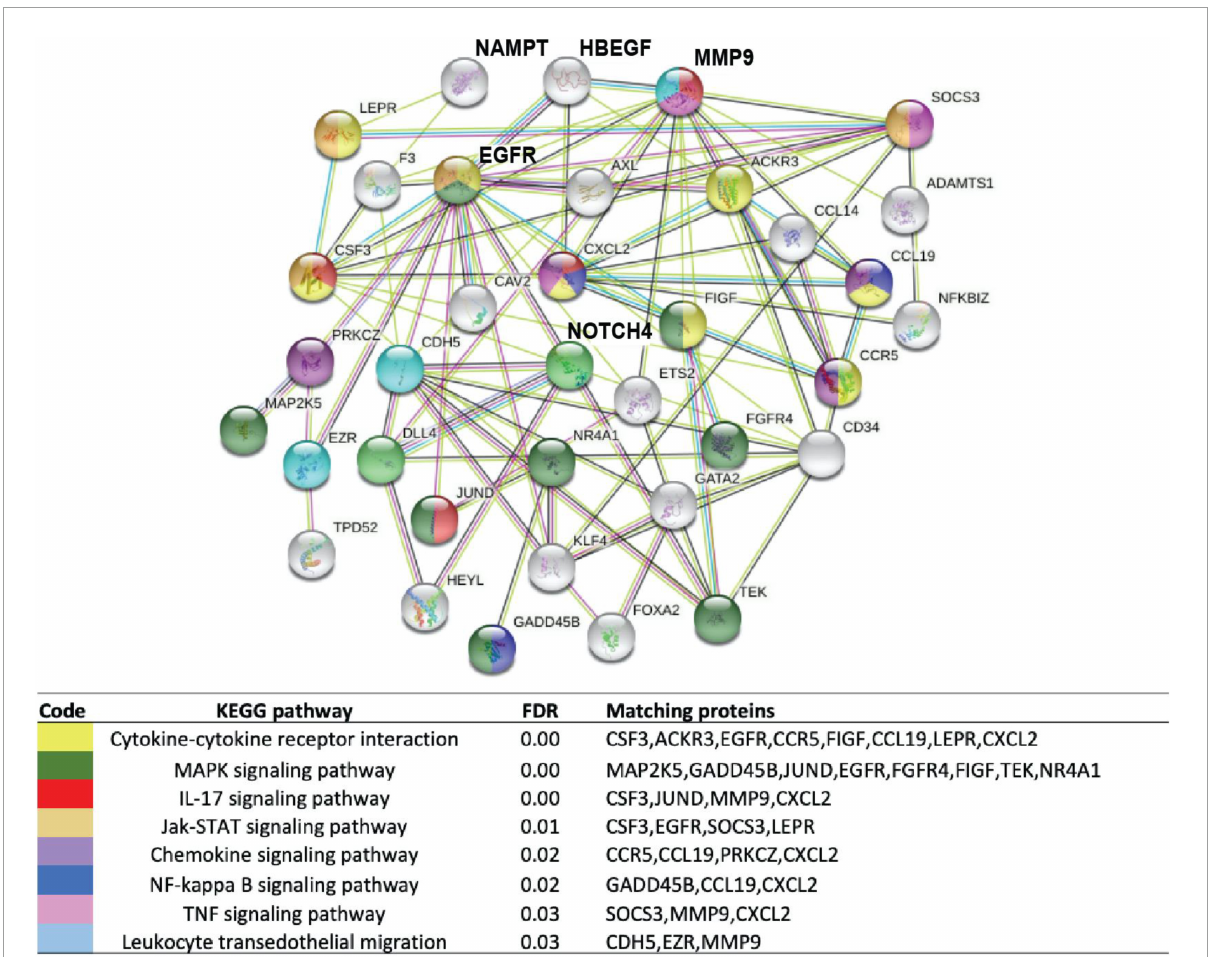
FIGURE5 Enrichment analysis of DEGs in lung tissues from subjects with sarcoidosis compared to healthy lung. Functional protein network interaction showing eNAMPT and HBEGF relationship with regulators of lung fibrosis (MMP9), inflammation, and lung remodeling and NOTCH4, a T-cell activity and angiogenesis regulator. Each node represents a coded protein. The edges represent protein–protein associations (line color indicates type of interaction: green—gene neighborhood, red—gene fusion, blue—co-occurrence, and black—co-expression). Pathway analysis and first shell interactors members included are indicated by the color code. A complete list of dysregulated pathways is presented in Supplementary Table 2